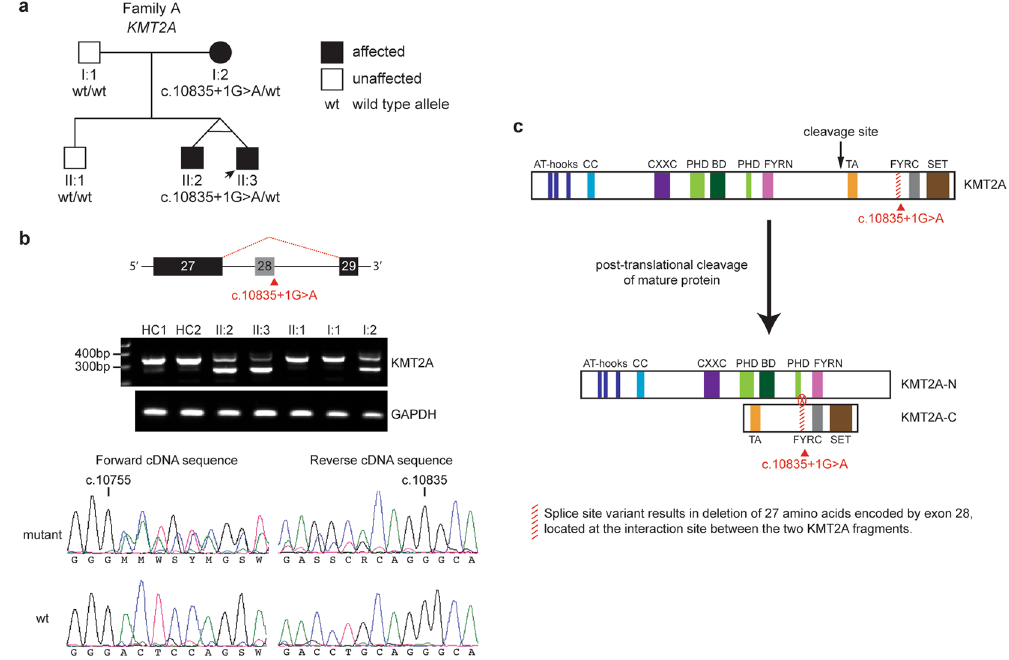
Figure 1. Family A with KMT2A -associated Wiedemann-Steiner syndrome (WSS). ( a ) Pedigree of family A. ( b ) Skipping of KMT2A exon 28. Gel electrophoresis of the KMT2A cDNA region containing exon 28 revealed a second shorter transcript in the three affected individuals. HC1 and HC2 represent two healthy controls; GAPDH was used as reference target. In-frame deletion of exon 28 was confirmed by cDNA sequencing; c.10755 and c.10835 indicate the start respectively stop position of exon 28. ( c ) KMT2A protein domains (adapted from ref. 9). KMT2A is cleaved in an N-terminal (KMT2A-N) and C-terminal (KMT2A-C) fragment, which form